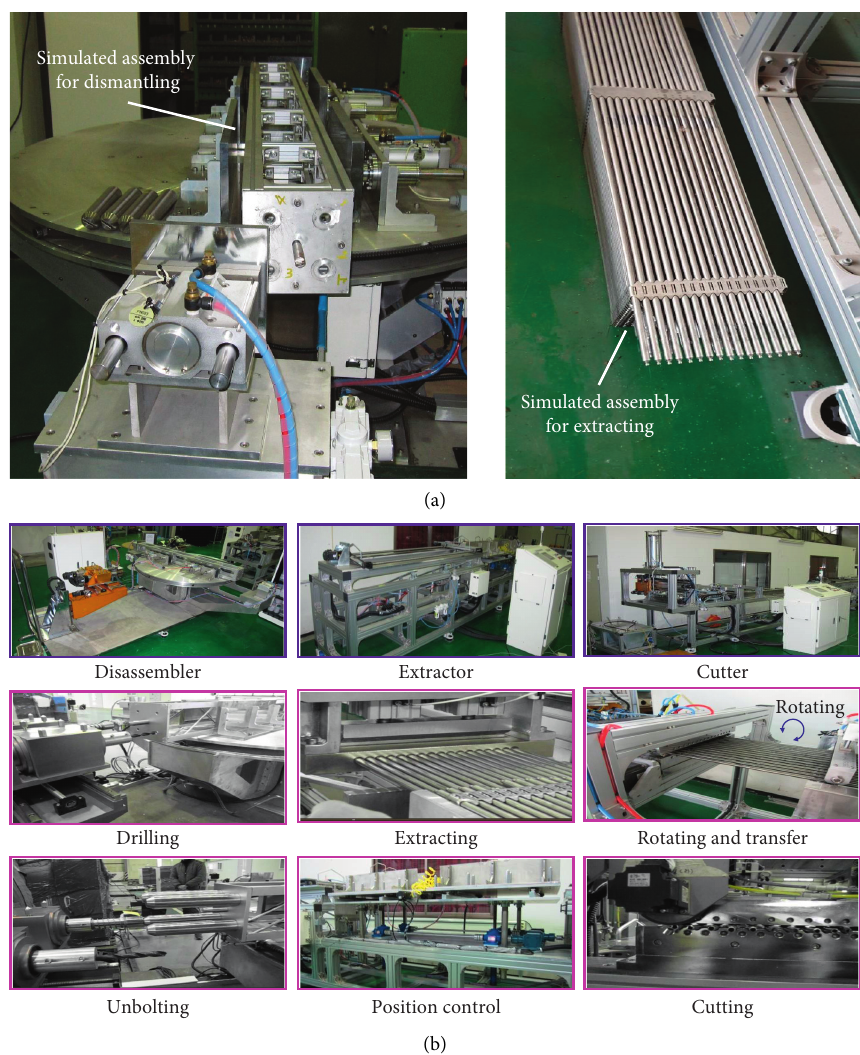
Figure 12: Disassembling unit process test. (a) simulated assemblies. (b) Dismantling, extracting, and cutting